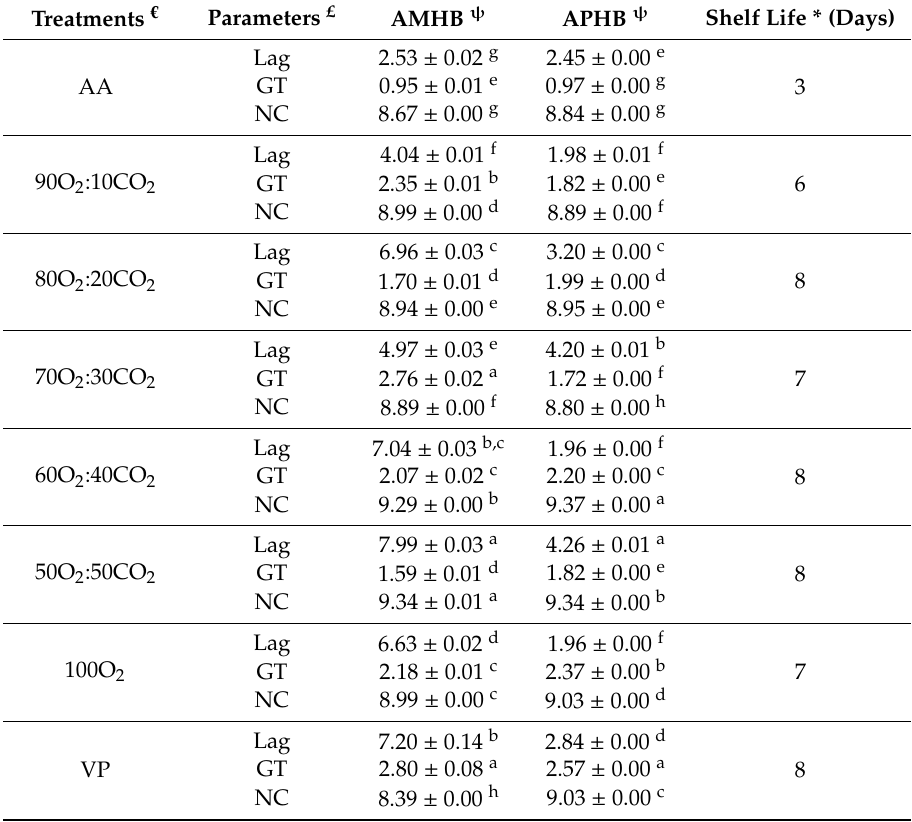
Table 2. Bacterial growth parameters of ground beef treated with di ff erent packaging systems stored at 2 ◦ C for 20